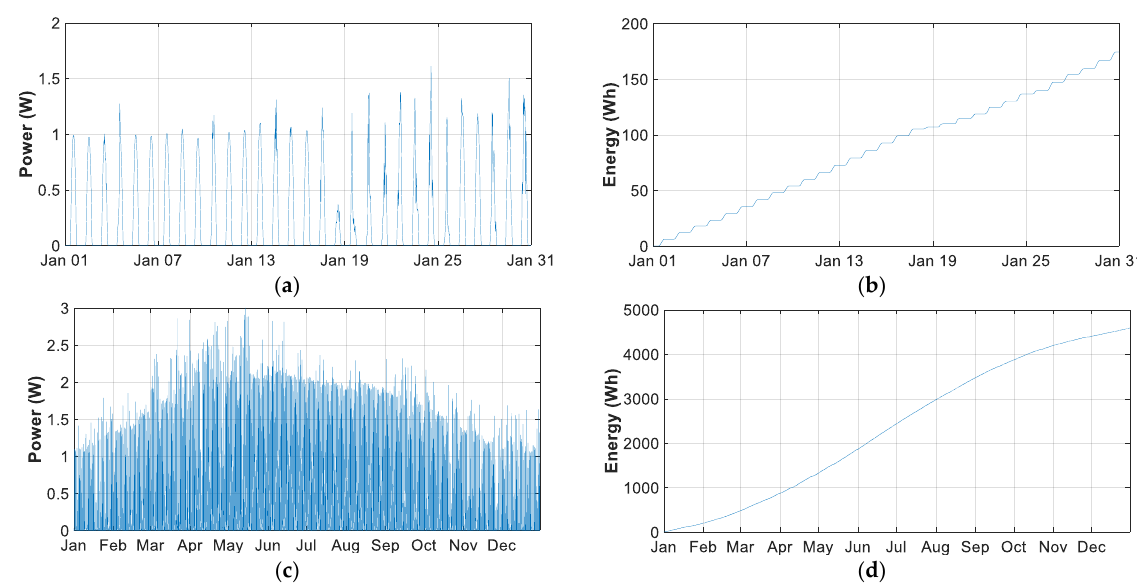
Figure 24. Consumption comparative: ( a ) power obtained in January; ( b ) energy obtained in January; ( c ) power obtained in the year 2020; and ( d ) energy obtained in the year 2020. The energy generated in January is 202.19 Wh, with a daily average of 6.5266 Wh. The annual photovoltaic generation amounts to 4594.73 Wh and a daily average of 12.5639 Wh.